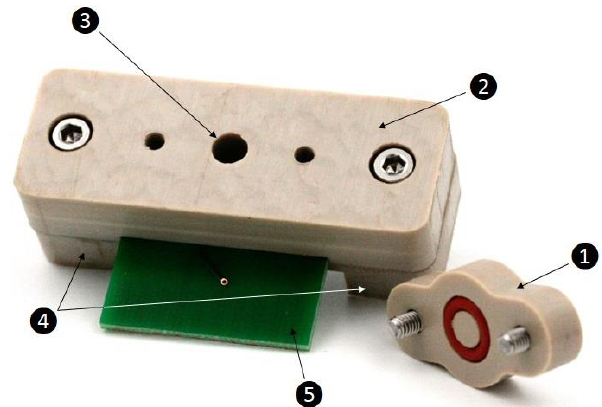
Figure 2. Thermal sensor connection setup. (1) Top cover with an O-ring and two screws, (2) cen- tral part with an O-ring on the underside (not shown) and two screws, (3) cylindrical sample chamber with a volume of 141 µL, (4) bottom part divided in two pieces, (5) printed circuit board with bonded sensor die (not shown).